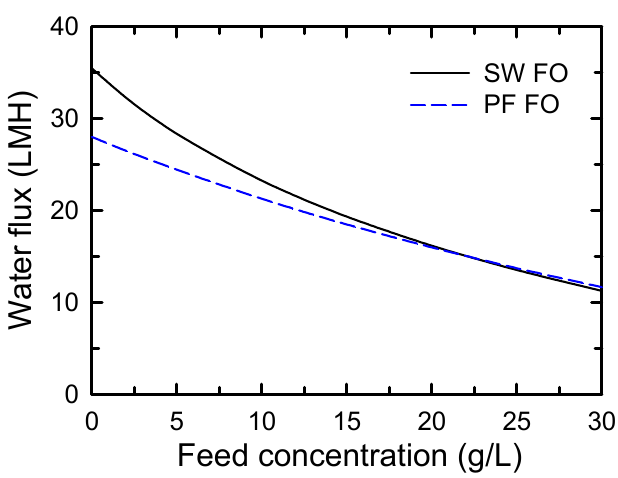
Figure 2. Water flux estimation of spiral-wound and plate-and-frame forward osmoses membranes as a function of feed solution concentration based on A, B , and S values in Table 2 and Equation (7). A 70 g/L of draw solution concentration was employed for the estimation.